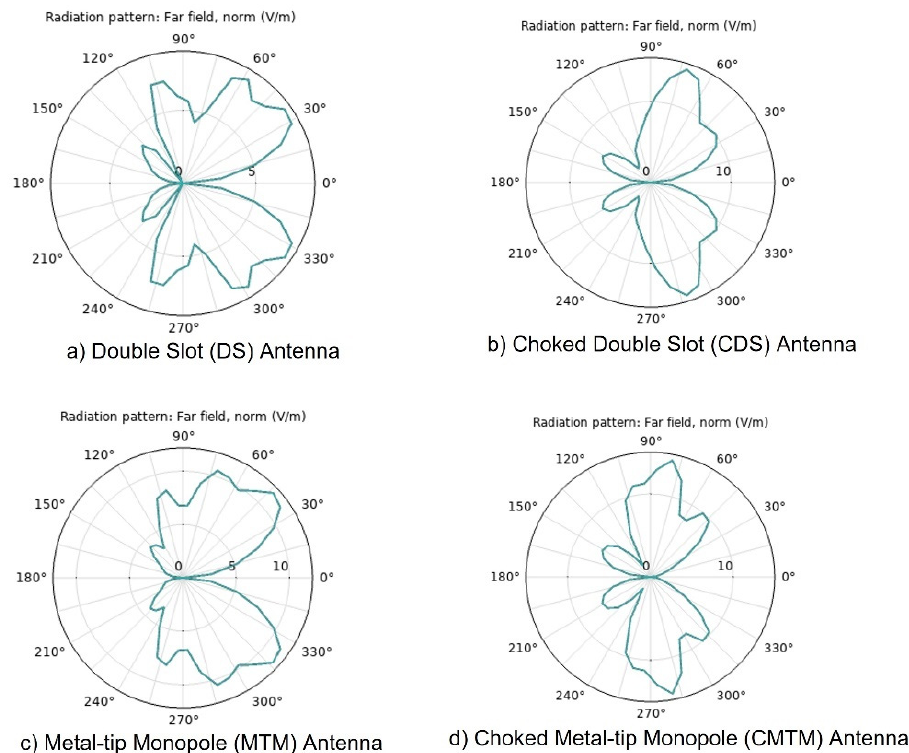
Figure 4. Directivity diagrams for the designed antennas. ( a ) Double Slot antenna, ( b ) Chocked Double Slot antenna, ( c ) Metal-Tip Monopole antenna, ( d ) Chocked Double Slot antenna, obtained by using COMSOL-Multiphysics.